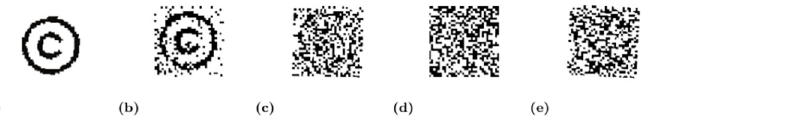
Fig 6. Extracted watermark images when the audio signal is clipped to 0.5 second at the beginning. (a) original watermark image; (b) image extracted by the proposed scheme; (c) image extracted by the DCT [12] scheme; (d) image extracted by the DWT [13] scheme; (e) image extracted by the DWT-DCT [10] scheme.